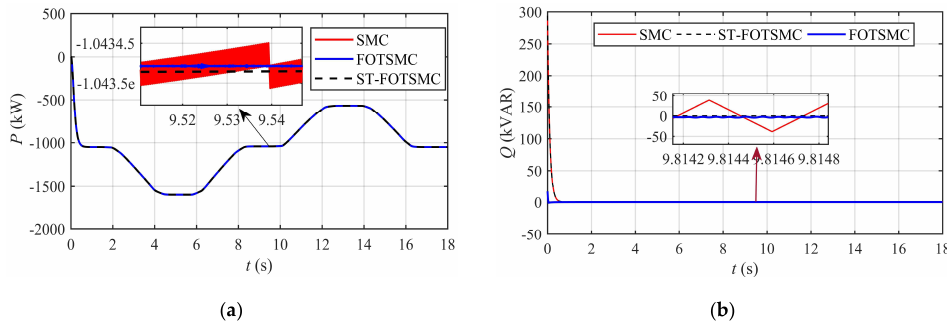
Figure 12. ( a ) Active power under lumped disturbances; ( b ) reactive power comparison under lumped disturbances.